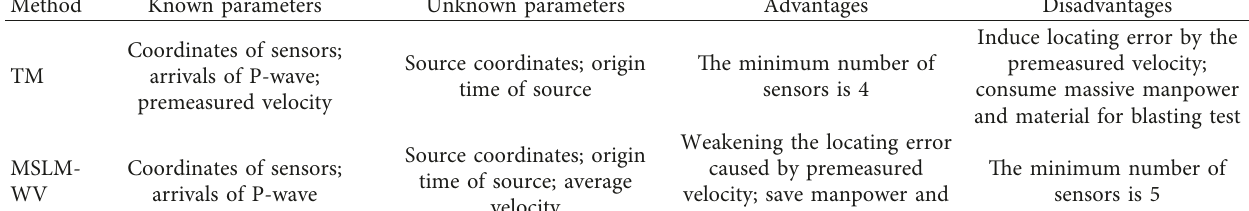
Table 1: Characteristics and comparisons of the MSLM-WV and TM methods (from